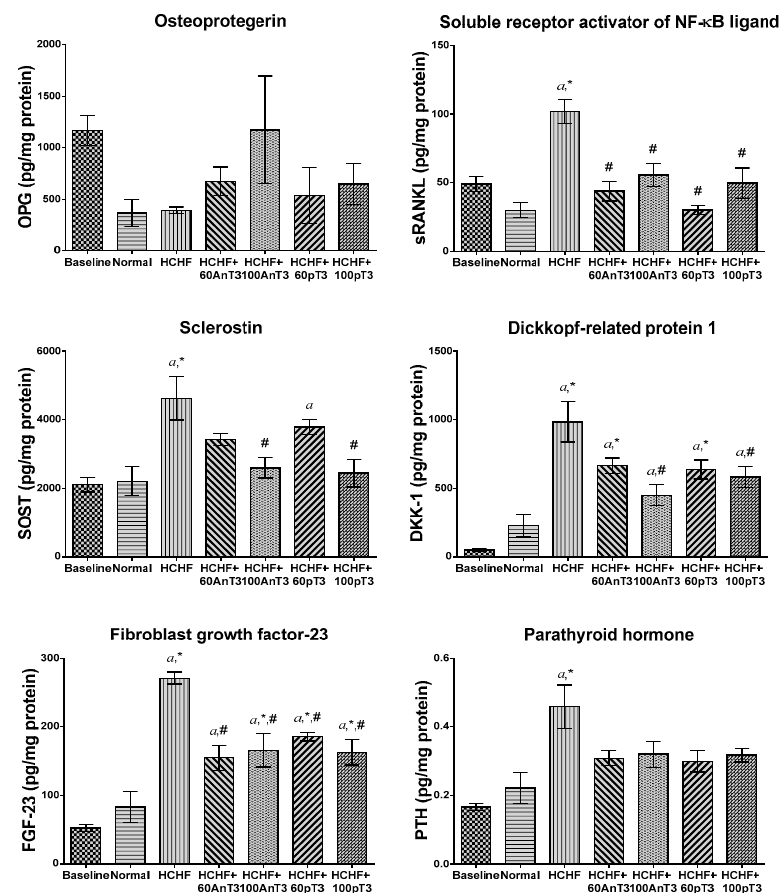
Figure 2. The weight of right tibia in the baseline, normal, high-carbohydrate high-fat (HCHF) animals with and without treatment of annatto and palm tocotrienol (60 and 100 mg / kg). Data are presented as mean ± SEM.